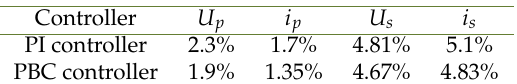
Table 6. Voltage and current of transmitting coil and receiving coil(THD%)